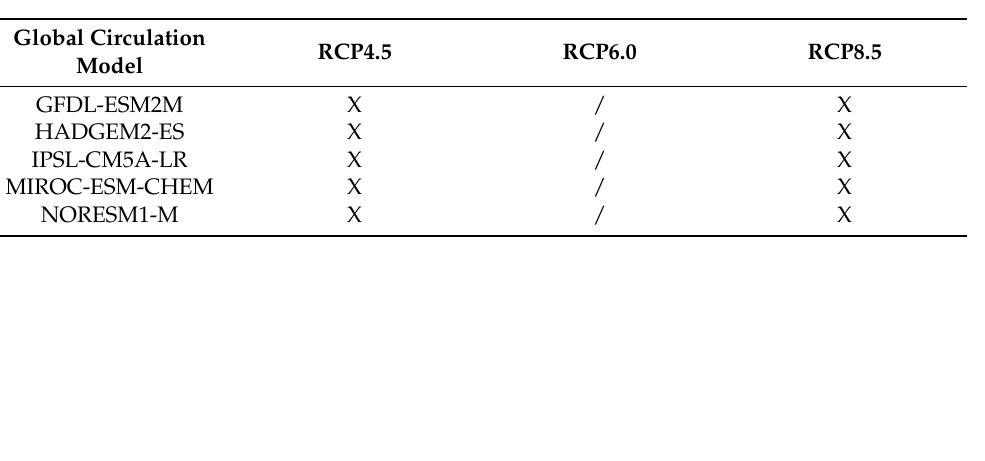
Figure A3. Model spread for annual precipitation and average between models per scenario: PGJdM (top) and DGL (bottom). Table A1. GCMs and scenarios used in this assessment and initially acquired from the climate data store, whereby X indicates that the climate dataset was used, while/indicates that the dataset was acquired but not used.